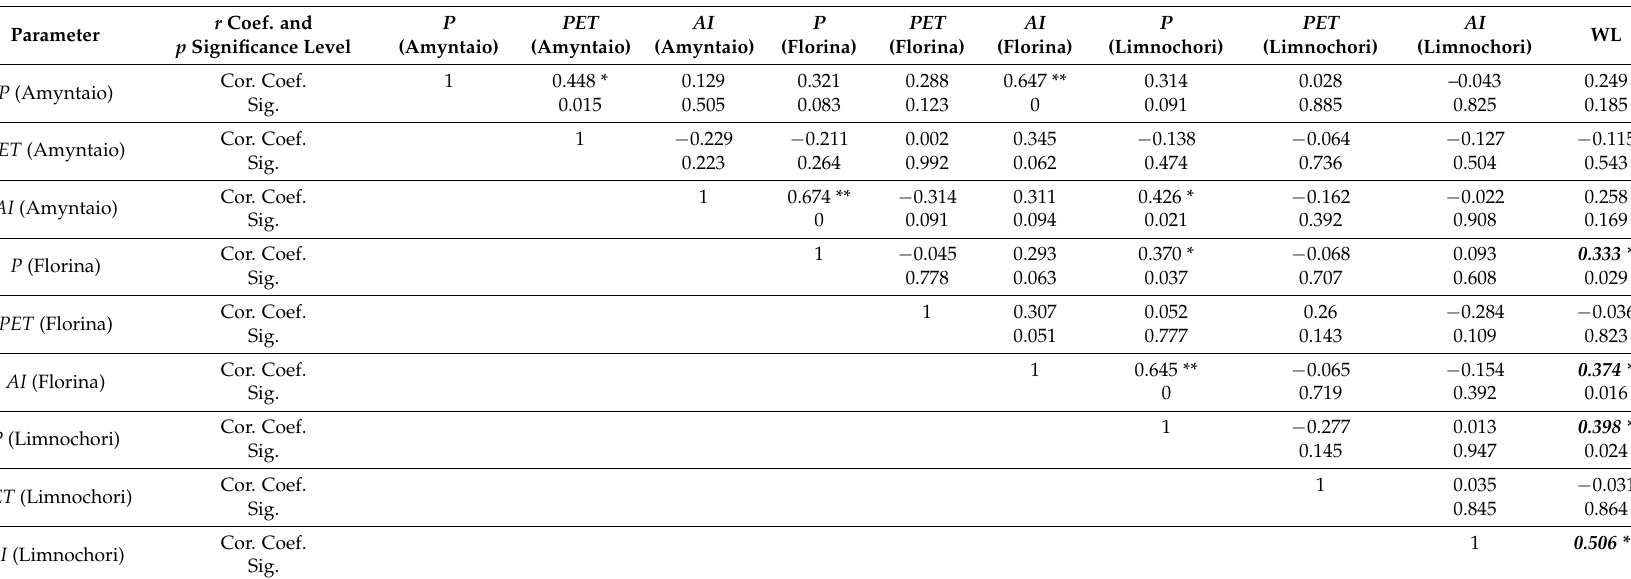
Table 3. Spearman rank correlations between annual mean water level (WL) of Lake Vegoritis, annual precipitation ( P ), potential evaportranspiration ( PET ) and Aridity Index ( AI ) from three meteorological stations (* indicates p ≤ 0.05, ** indicates p ≤